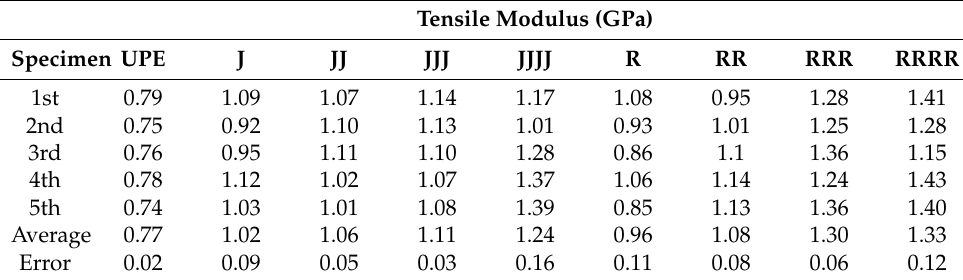
Table 4. Tensile modulus for hybrid jute–ramie composite.